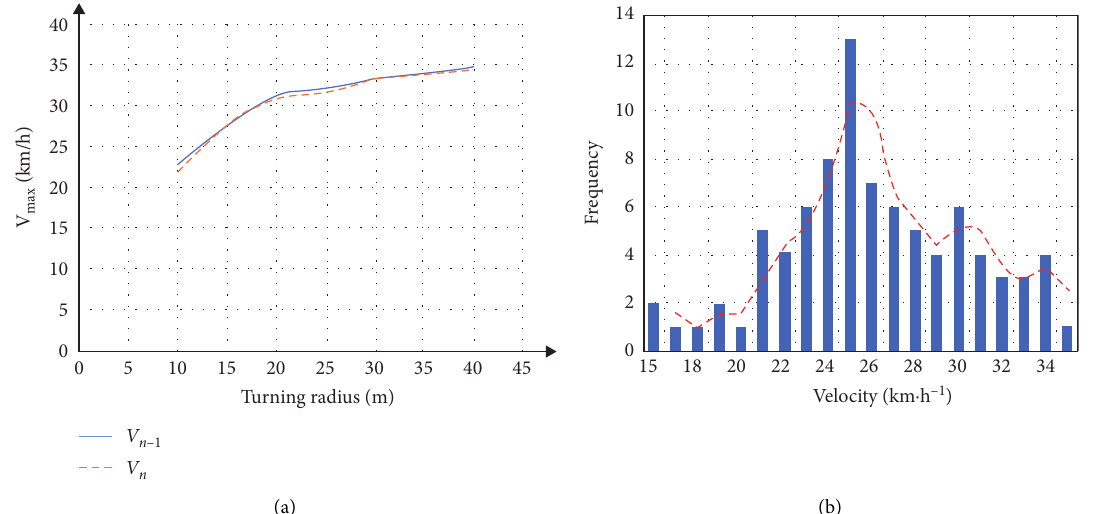
Figure 2: The relationship between velocity and radius: (a) variation of maximum velocity under different turning radii and (b) the frequency distribution of velocity, when radius is 40m.